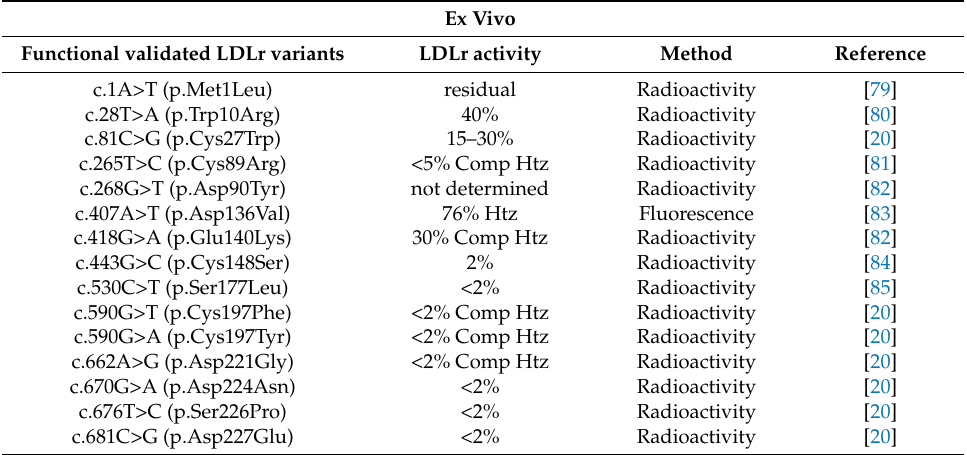
Table 3. ClinVar annotated LDLr variants functionally characterized ex vivo or in vitro by radioactive, fluorescence-based or other